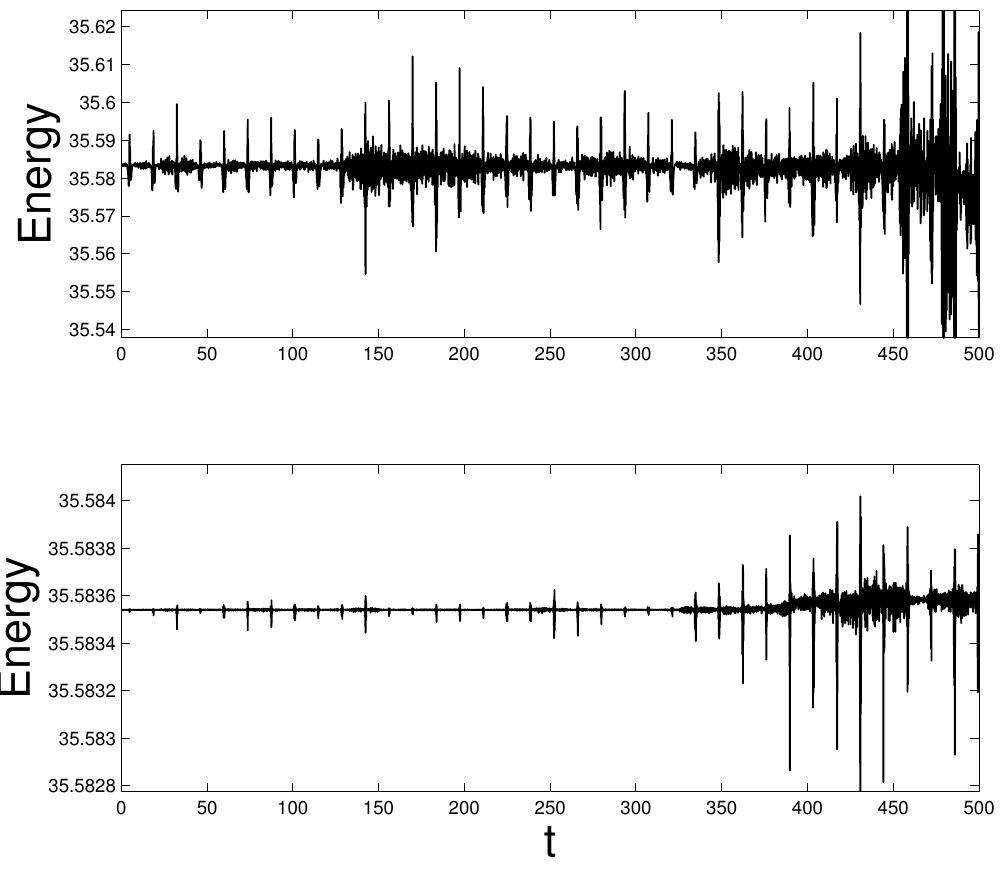
Figure 13. The discrete energy E N for the Lagrange multiplier strategy: Integration in time was performed with the 2nd ( top ) and 4th ( bottom ) order Lobatto IIIA–IIIB method for constrained mechanical systems. The spikes correspond to the times when the solitons bounce off of each other or of the